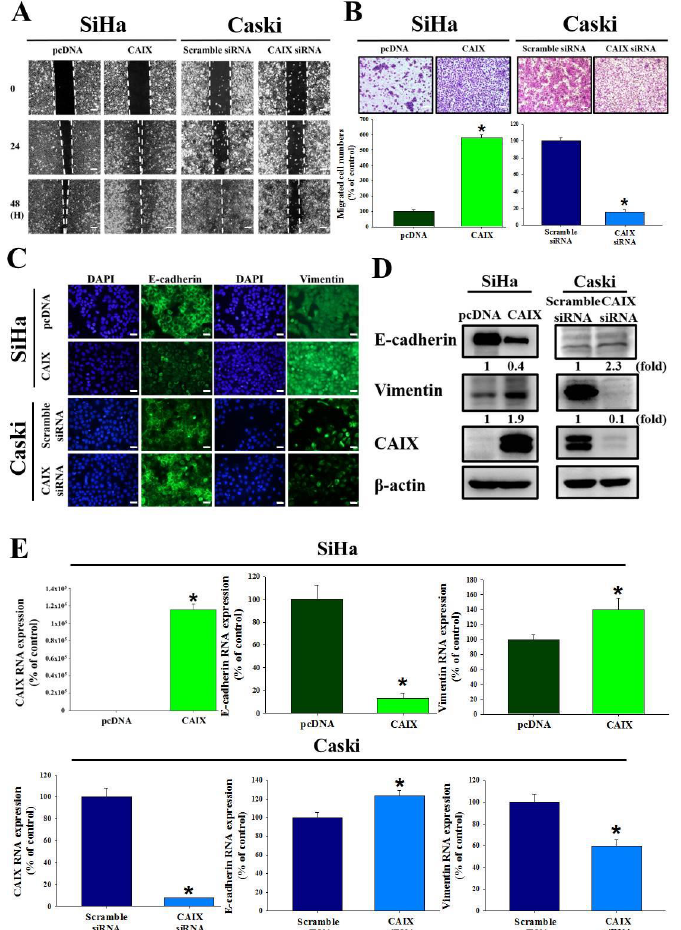
Figure 2. CAIX regulated cell migration and epithelial–mesenchymal transition in SiHa and Caski cells. ( A ) After CAIX overexpression or CAIX-silencing, cell motility was assessed by the wound healing assay and ( B ) Boyden chamber assay. Scale bar, 100 µ m. ( C ) EMT proteins were detected using immunofluorescence staining. Scale bar, 50 µ m. ( D ) The protein levels of E-cadherin and vimentin were detected by using Western blot assay. ( E ) The mRNA levels of E-cadherin and vimentin were detected by using real-time PCR. (*, p <